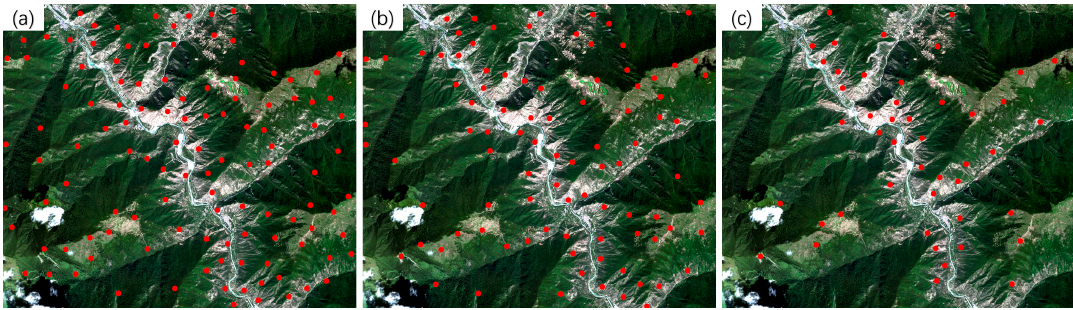
Figure 15. Matched tie points of the GF-2 image. ( a ) The proposed method; ( b ) Patch-SIFT; and ( c ) SIFT.